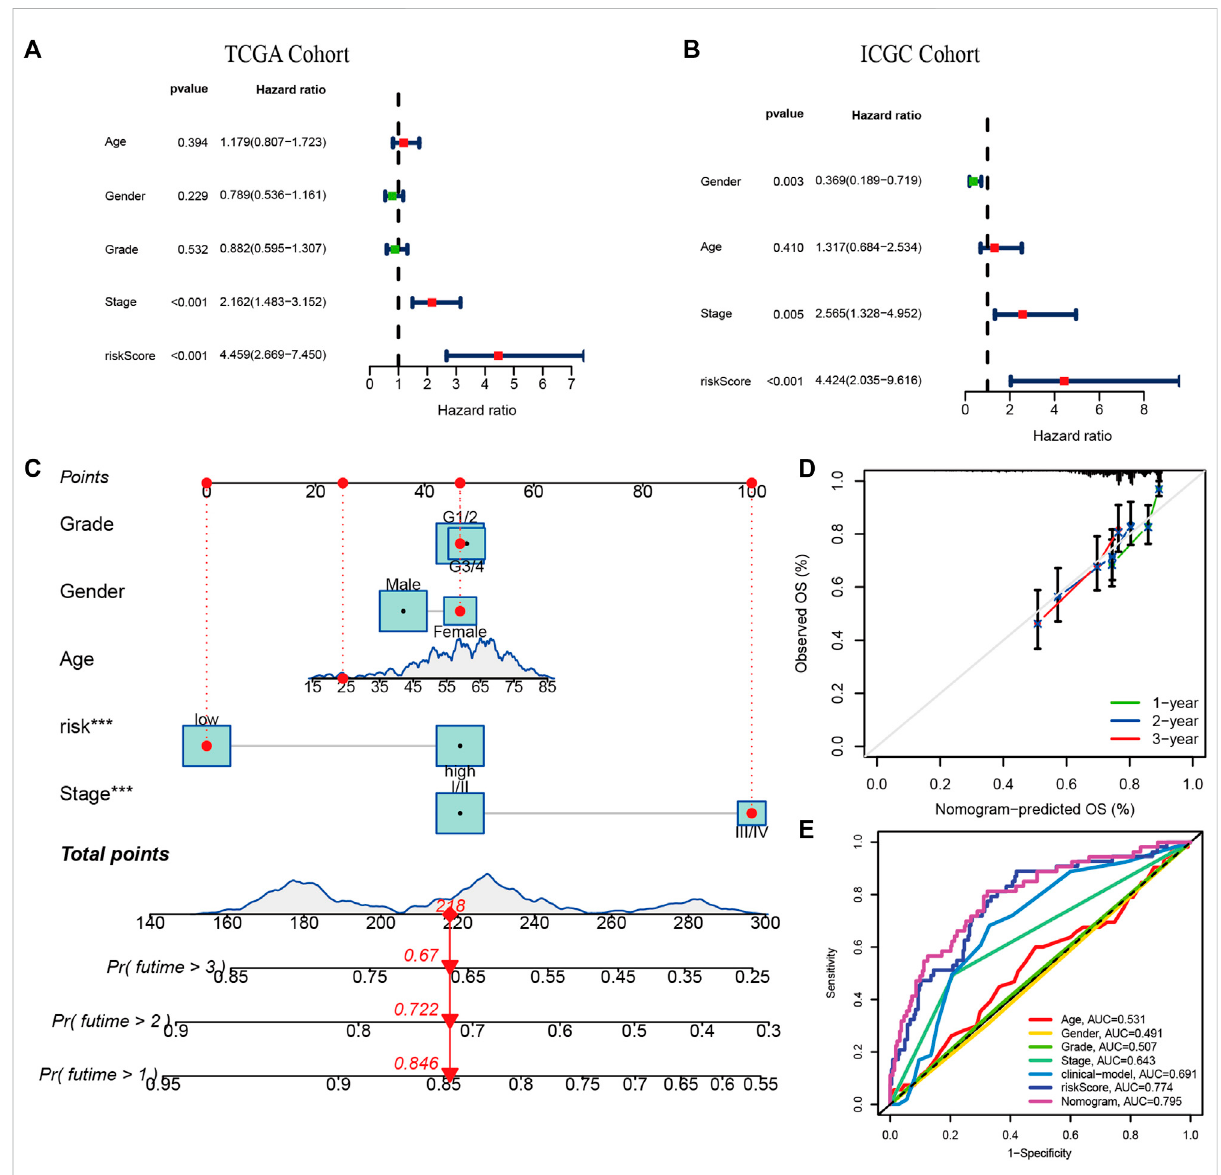
FIGURE 5 Independent prognostic value of risk signature and Nomogram construction. The multivariate Cox regression analysis in the TCGA cohort (A) and the ICGC cohort (B) ; (C) The nomogram for predicting 1-, 2-, and 3-years OS in the TCGA cohort. (E) The calibration plots. (D) Multi-indicator ROC curves for predicting 1-year OS in the TCGA